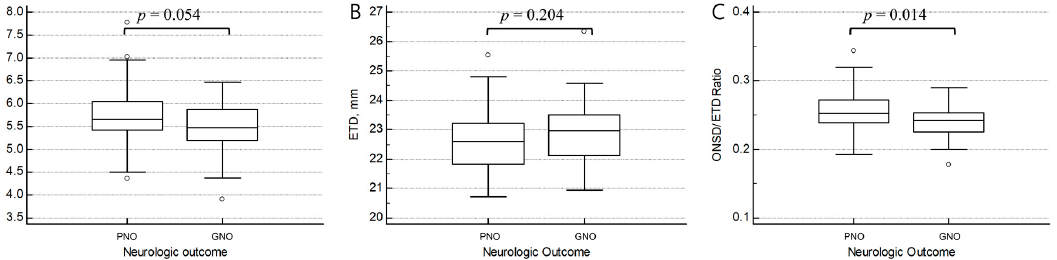
Figure 2. Comparisons of the optic nerve sheath diameter ( A ), eyeball transverse diameter ( B ), and ONSD/ETD ratio ( C ) between the good and poor neurologic outcome groups. Abbreviations: ETD, eyeball transverse diameter; GNO, good neurologic outcome; ONSD, optic nerve sheath diameter; PNO, poor neurologic outcome. Table 2. Comparison of the ONSD/ETD ratio between good and poor neurologic outcomes. Table 3. Univariable and multivariable analysis for good neurologic outcome with variables and the Total (n = 100) GNO (n = 28) PNO (n = 72) p -Value ONSD/ETD Optic nerve sheath diameter, mm